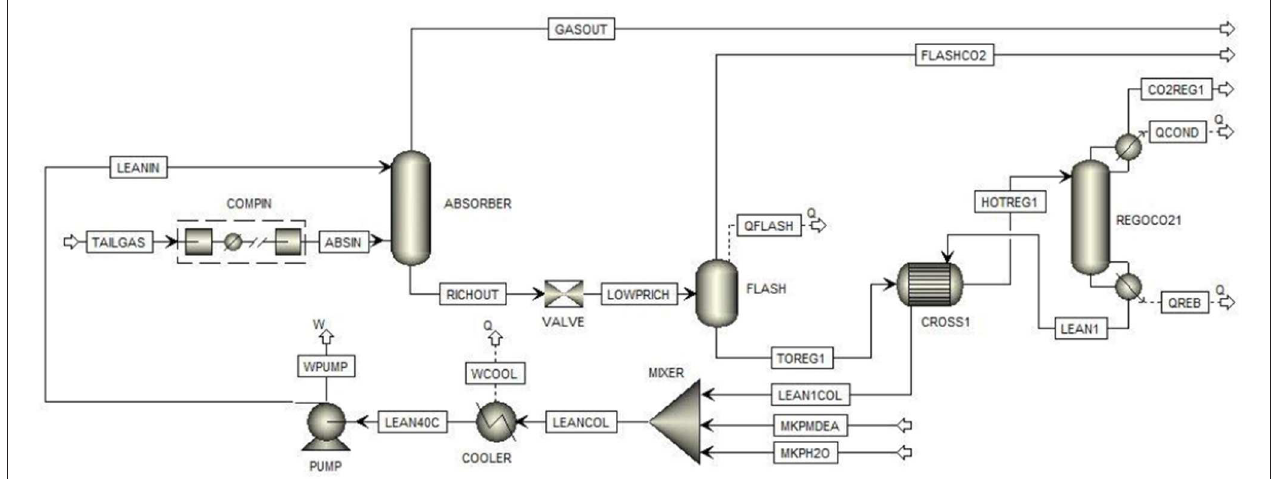
FIGURE 1 | Flow sheet of the simulated CO 2 capture